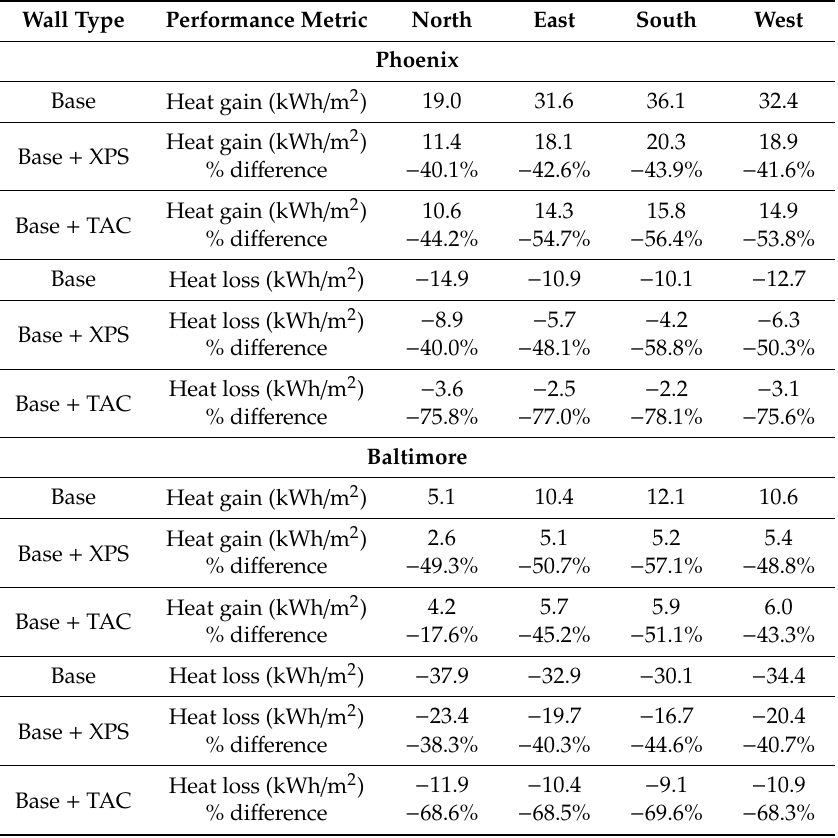
Figure 12. Calculated monthly heat gains through a south-facing wall in Phoenix and heat losses through a north-facing wall in Baltimore. Table 3. Comparison of calculated annual wall heat gains and losses and percent difference with respect to the “Base” wall.